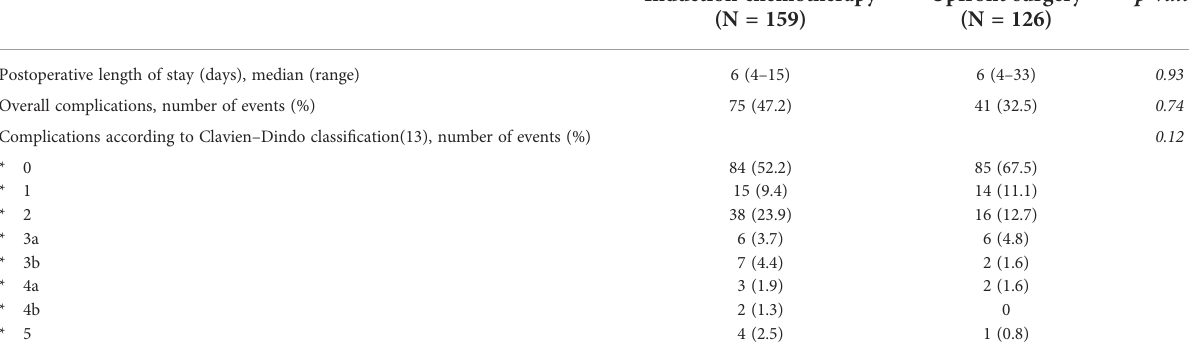
Induction chemotherapy (N =